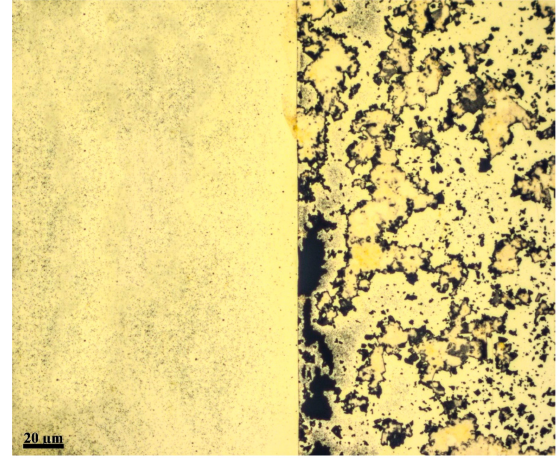
Figure 3. Etching of thin gold film over COC wafer. The left side of the figure shows uniform etching of gold, while the right side, coated with GO layer, shows a porous gold thin film.